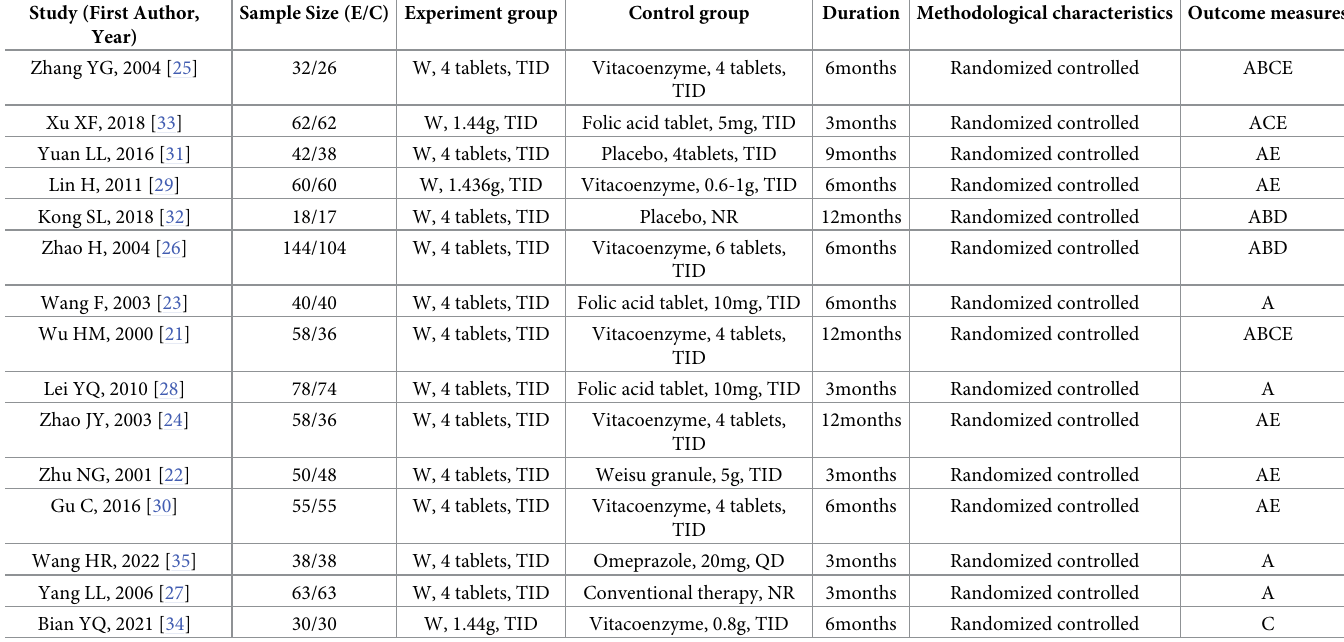
Table 1. Principal characteristics of all eligible studies.